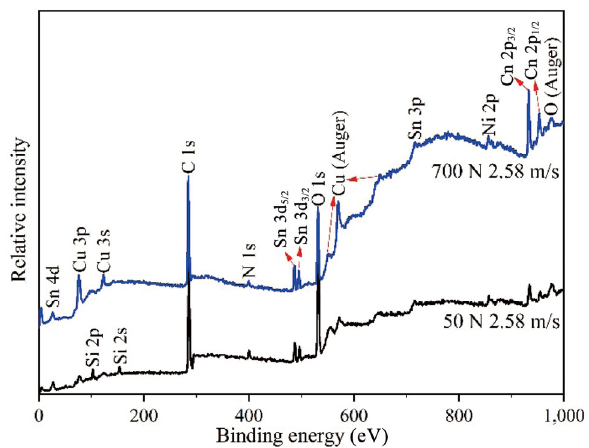
Fig. 11 Full XPS spectra of worn tracks on Cu–15Ni–8Sn– 0.8Nb alloy under different sliding conditions.